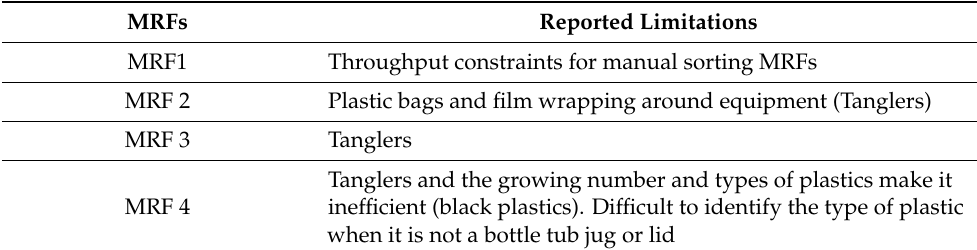
Table 1. Common limitations in sorting plastic wastes reported by